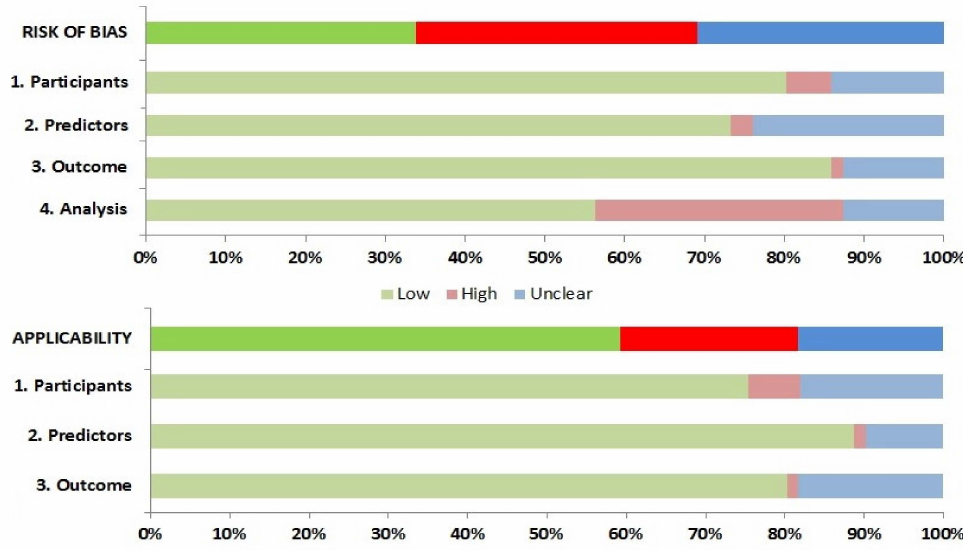
Figure 2. Risk of bias assessment according to the Prediction model Risk of Bias Assessment Tool